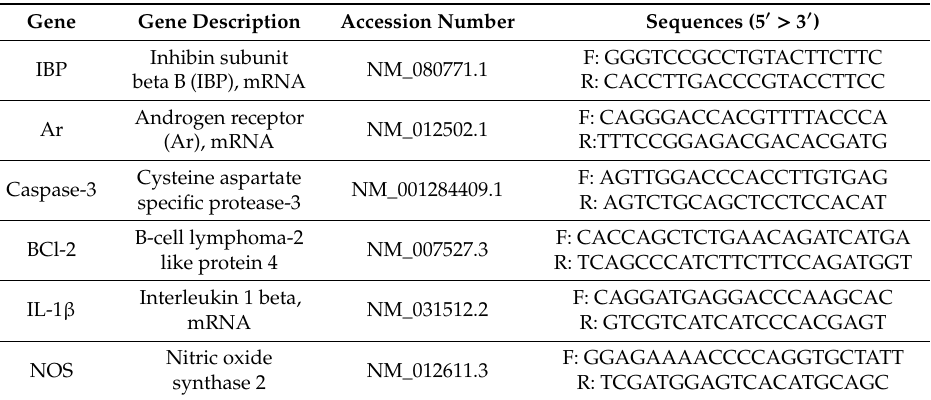
Table 1. Sequences of primers used for real time PCR investigations of caspase-3 (Casp3), androgen receptor (Ar), inhibin B protein (IBP), nitric oxide synthase 2 (NOS), B-cell lymphoma 2 (BCL-2), and interleukin-1 β (IL-1 β ) genes.